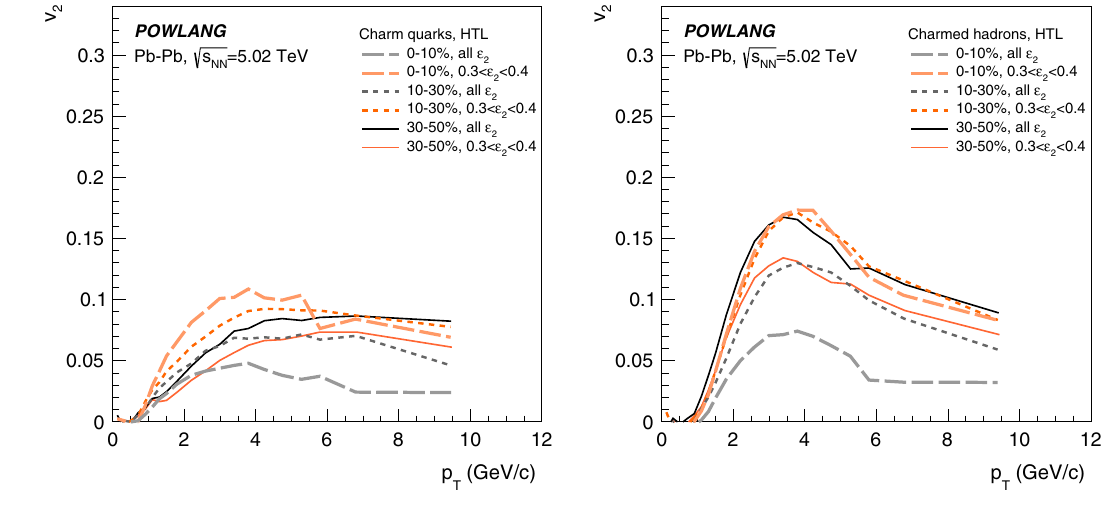
Fig. 14 The elliptic-flow coefficient v 2 of charmed quarks (left panel) same (cid:7) 2 but belonging to different centrality classes display sizable dif- √ s NN = 5 . 02 TeV for and hadrons (right panel) in Pb–Pb collisions at ferences, the response to the initial eccentricity being stronger for more central events. The difference is partially washed-out by hadronization various centrality classes. For each class we display results referring via recombination to the fixed eccentricity interval 0 . 3 ≤ (cid:7) 2 ≤ 0 . 4 and to an unbiased selection of the events. At the quark level results for events with the